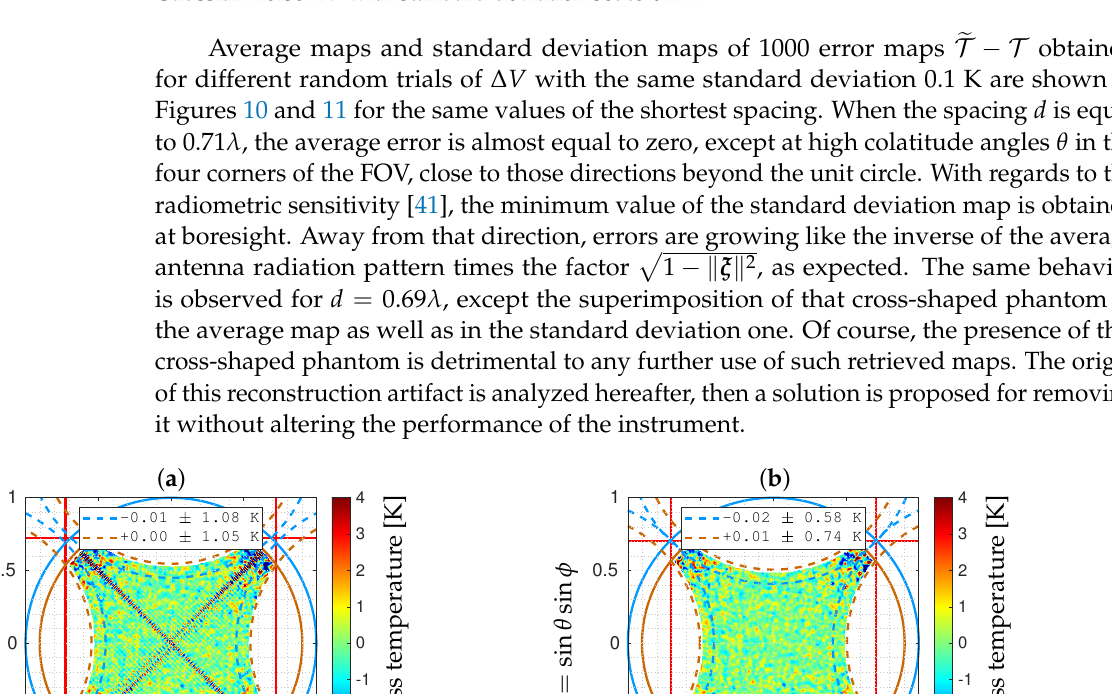
Figure 9. Error maps (cid:101) T − T obtained in X polarization with the cross-shaped array shown in Figure 4 for two values of the shortest spacing: ( a ) d = 0.69 λ and ( b ) d = 0.71 λ (similar results are obtained in Y polarization). In both cases, complex visibilities V have been blurred by an additive Gaussian noise ∆ V with standard deviation set to 0.1 K.